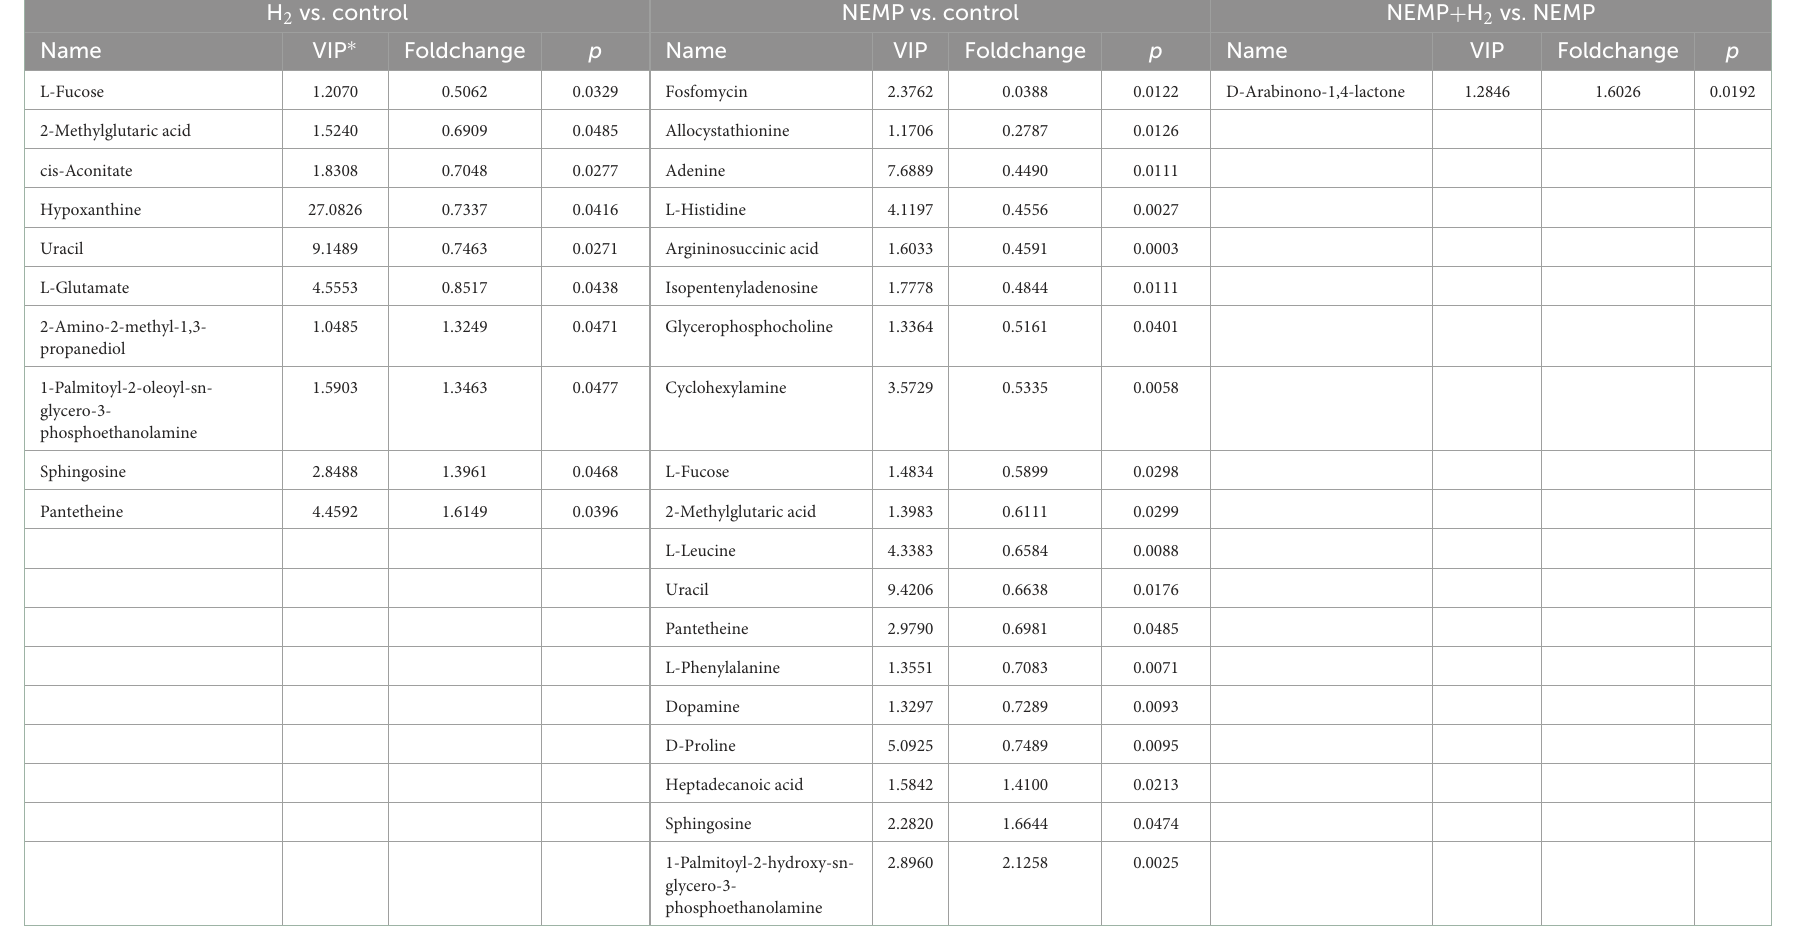
TABLE 1 Differential metabolites between H 2 vs. control, NEMP vs. control, and NEMP + H 2 vs. NEMP. H 2 vs. control NEMP vs. control NEMP + H 2 vs.